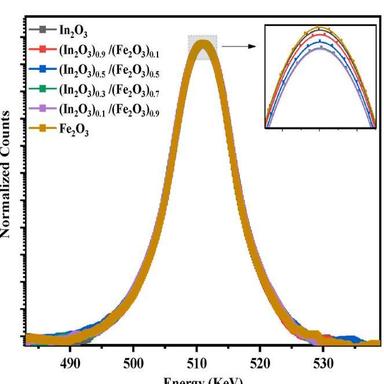
shows both bare In2O3 and Fe2O3 nanostructures have high free volume fractions compared to nanocomposites while the (In2O3)0.3/ (Fe2O3)0.7 samples have slightly high free volume fraction compared to other nanocomposites.